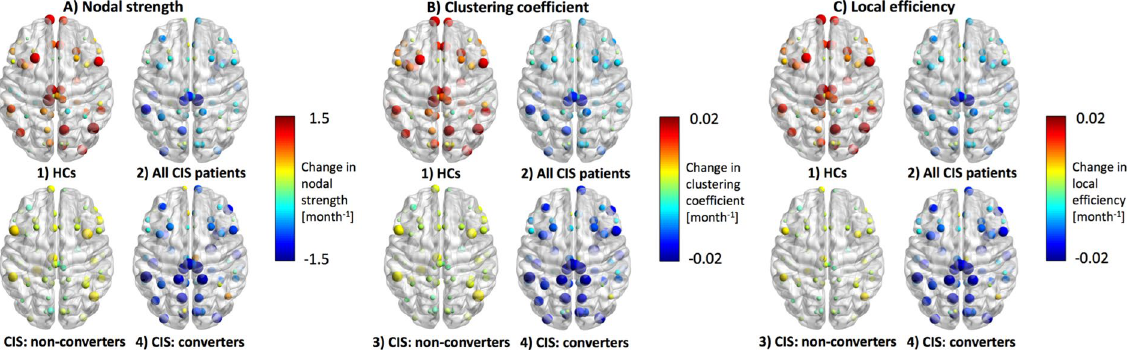
Figure 3. Estimated monthly changes in nodal metrics for all groups. This figure shows the estimated monthly changes in the three node-level metrics: ( A ) nodal strength, ( B ) clustering coefficient and ( C ) local efficiency. In this figure, the size of the nodes indicates the absolute value of the change: bigger nodes have greater changes, in either direction, and smaller nodes have changes close to zero. Instead, the color of the nodes indicates the direction of the change: redder nodes indicate positive changes (increase) and bluer nodes indicate negative changes (decrease). The behavior over time of all-CIS network differed from that of HCs’ network, yet these differences did not reach statistical significance (see Table 2). This different behavior was mirrored by the two patient groups: whereas the non-converters’ network only showed minimal changes over time, the converters’ network showed an overall decrease in nodal strength, clustering coefficient and local efficiency. Of note, the regional distribution of nodes with greatest changes over time (pre- and post-central gyri and paracentral lobule, bilaterally) was similar for the all-CIS and the converters’ networks. Abbreviations: CIS: clinically isolated syndrome; HCs: healthy controls.